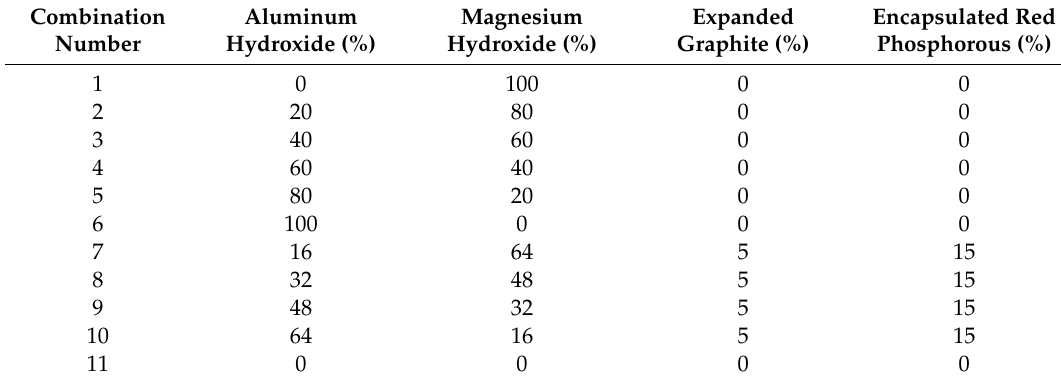
Table 2. Fire-retardant